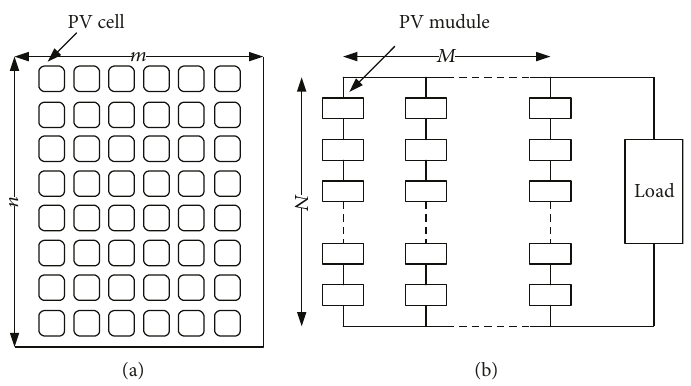
Figure 3: (a) Schematic diagram for photovoltaic module. (b) Schematic diagram for photovoltaic array.